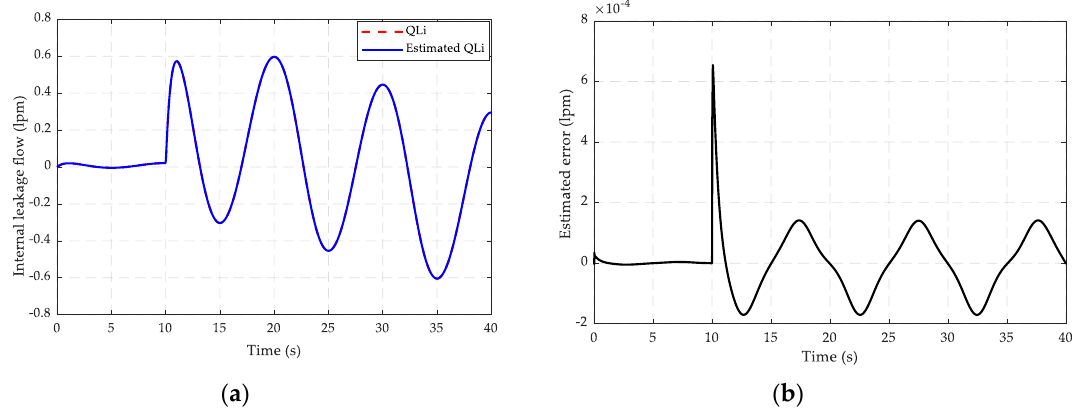
Figure 5. Comparison of estimated internal leakage flow. ( a ) Estimated result. ( b ) Estimated error.